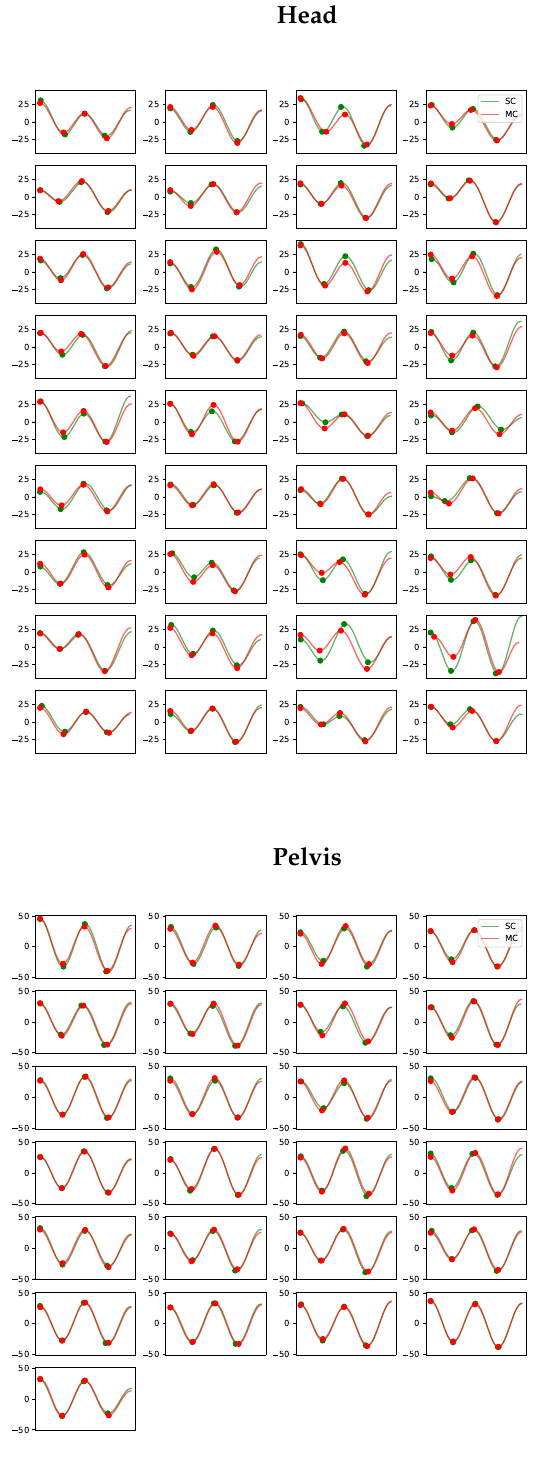
Figure A21. Vertical displacement signals per stride for the head and pelvis for horse 22. Each subplot contains the matched stride segments for the single-camera markerless system (SC) in green and the multi-camera marker-based system (MC) in red. The y-axis shows the vertical displacement in millimeters. The four dots on each curve indicate the positions of the two peaks and two valleys extracted using the approach in Section